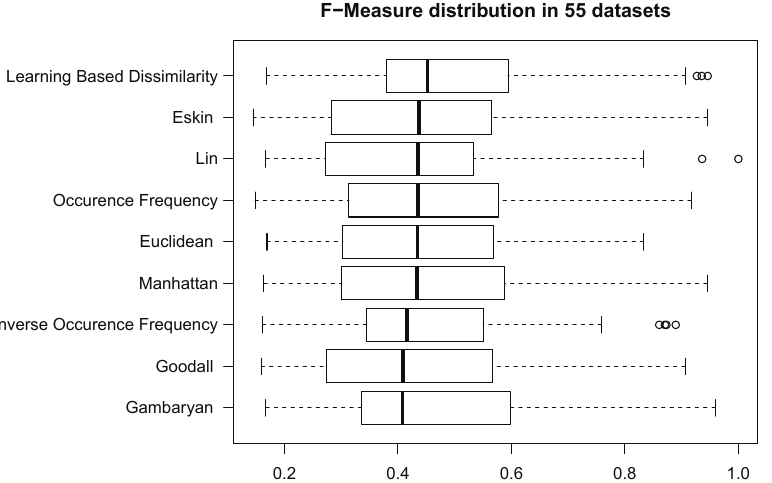
Figure 2. Box and whisker diagrams of all groups of F-measures [16]. Each F-measure group is associated with a dissimilarity measure and gathers the output of KMeans++ [15] having made a run on every dataset selected for our experimentation. Box and whisker diagrams are shown following a descending ordering, considering the associated F-measure median.